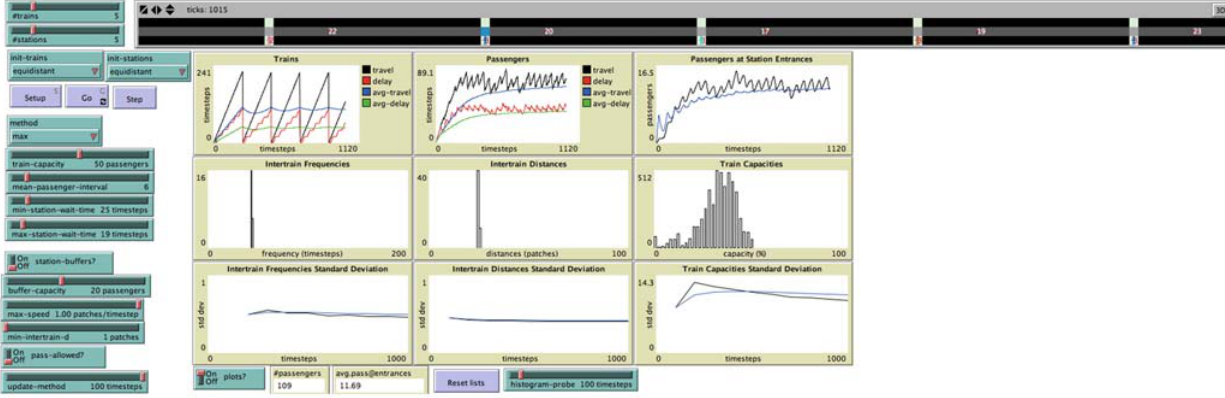
Figure 3. Screenshot of the simulation with equal headway stability, l ~ 6 . Notice that the intervehicle frequencies and distances are regular, shown with a peak in the histograms and low standard deviations (notice y -axis scale). Because of this regularity, the vehicle utilization histogram has a bell-shaped distribution, which reflects the passenger inflow interval probabilities.